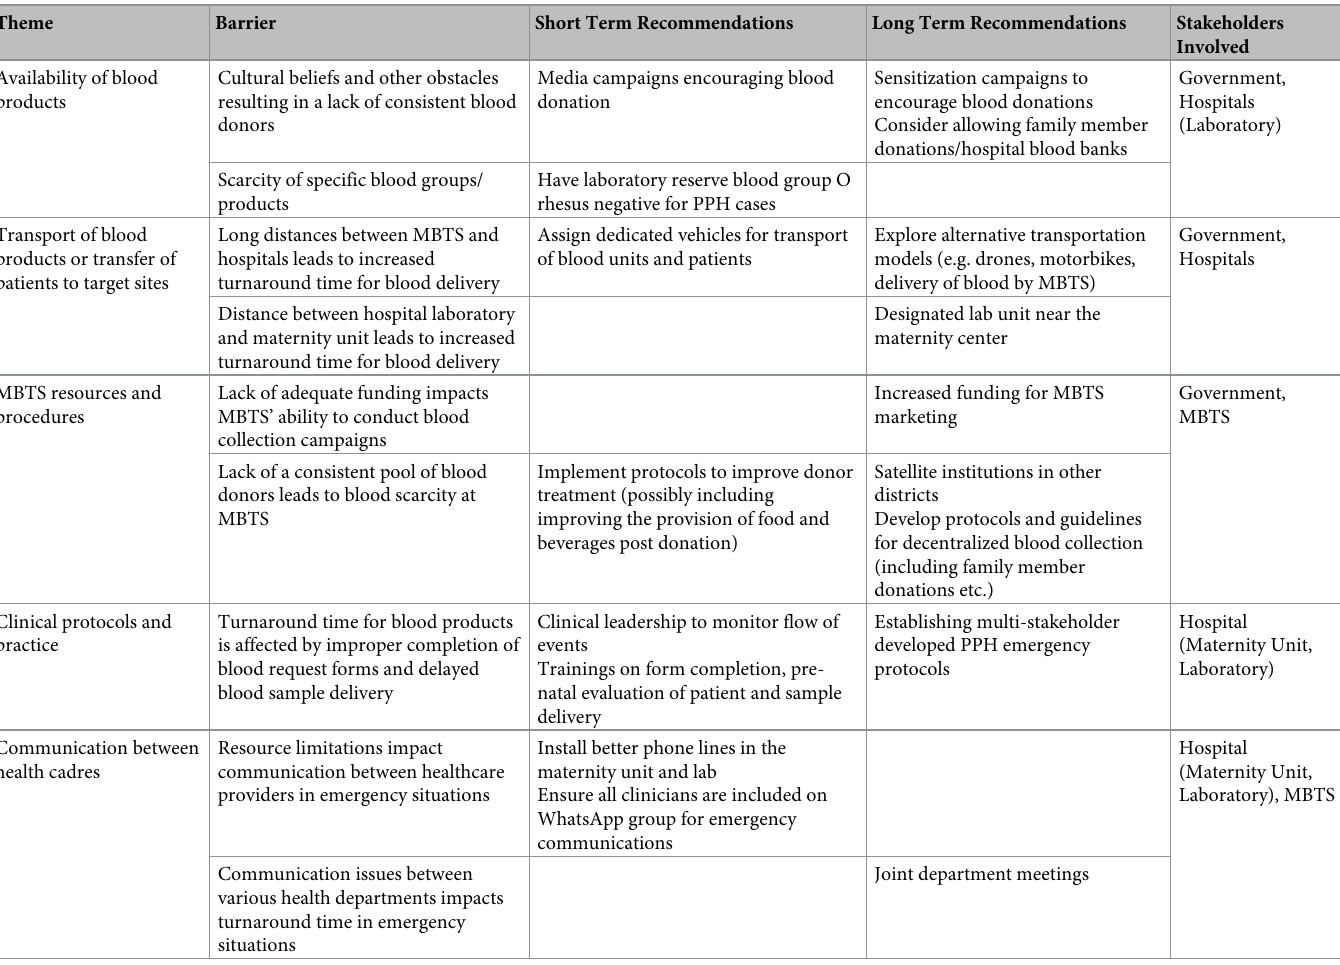
Table 2. Themes of barriers and challenges and recommendations for interventions to improve timely blood access.